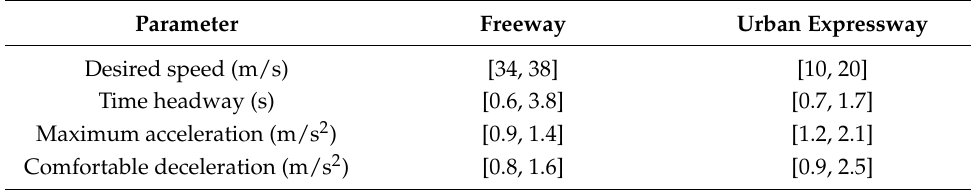
Table 5. Parameters of the IDM.